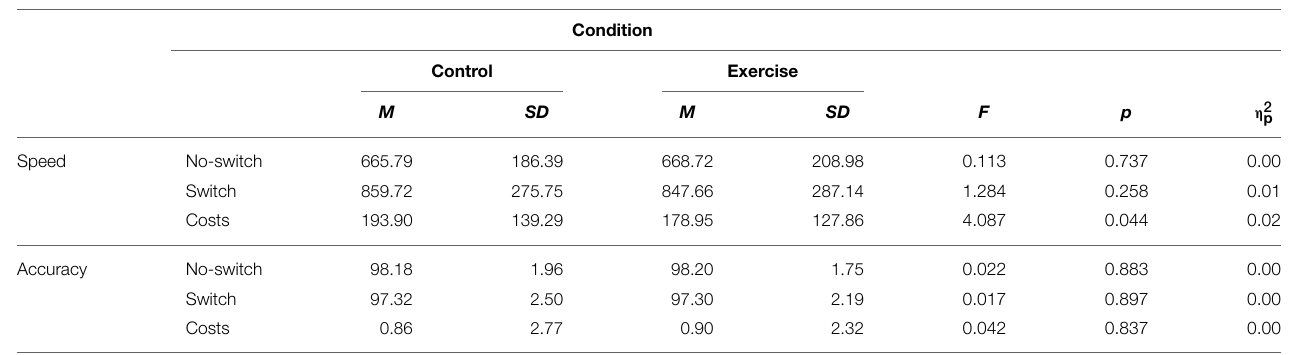
TABLE 1 | Speed and accuracy in the switching task by experimental conditions ( N = 227